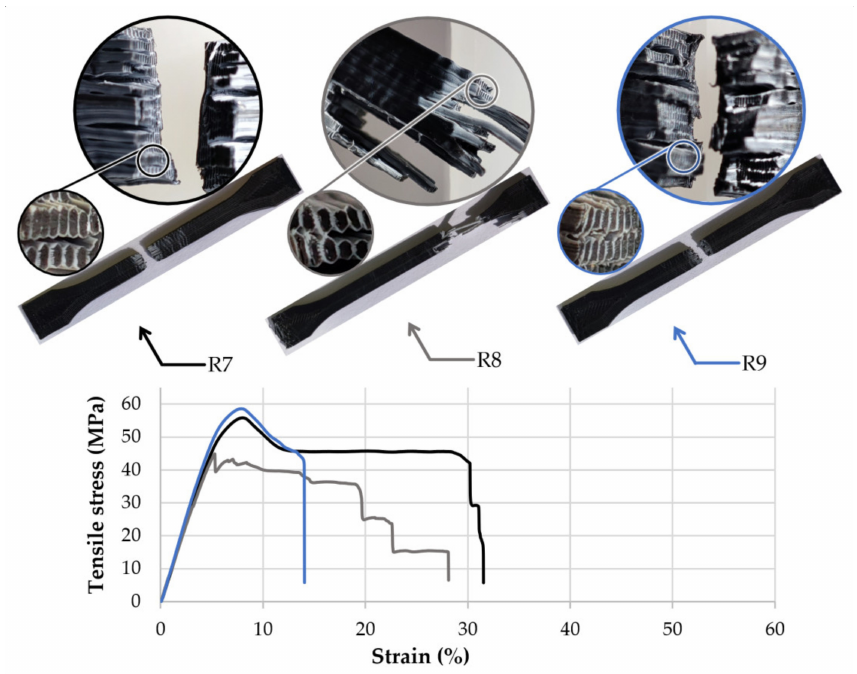
Figure 6. Tensile stress-strain curves, breaking behaviour, and layer structure of the 75PC-25ABS 3D printed filament